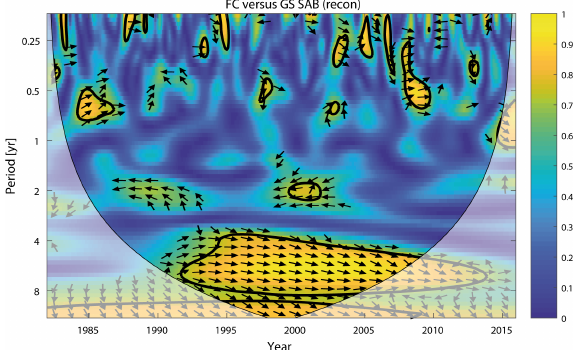
Figure A1. Squared wavelet coherence between the FC transport and GS-SAB time series. The 5% significance level against red noise is shown as a thick contour. All significant sections above 4 years show in-phase behavior, which is indicated by arrows that are directed to the right.